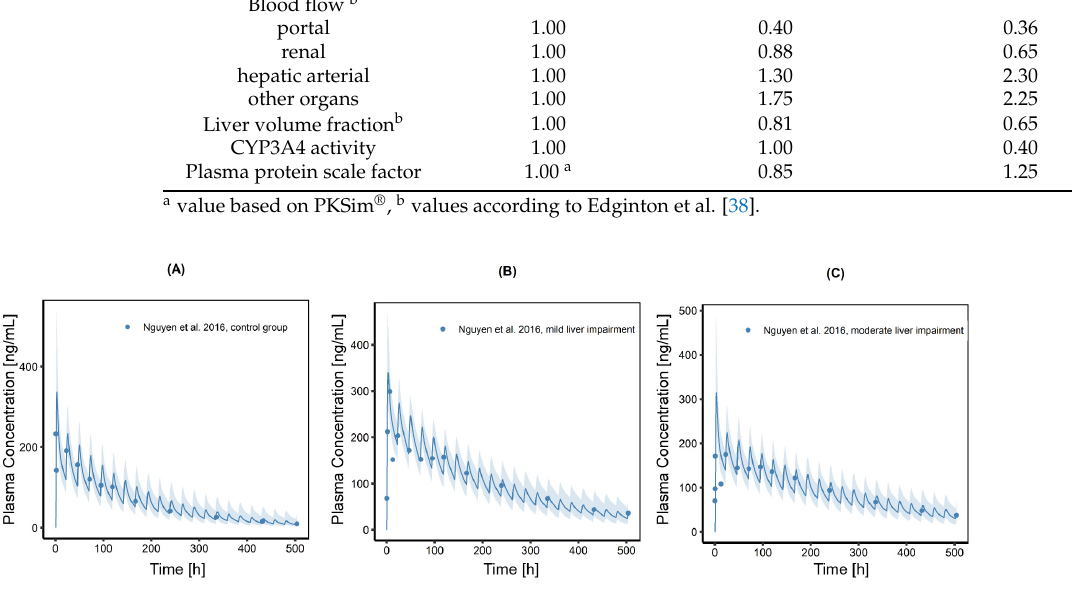
Table 3. Physiological changes of parameters associated with hepatic impairment.